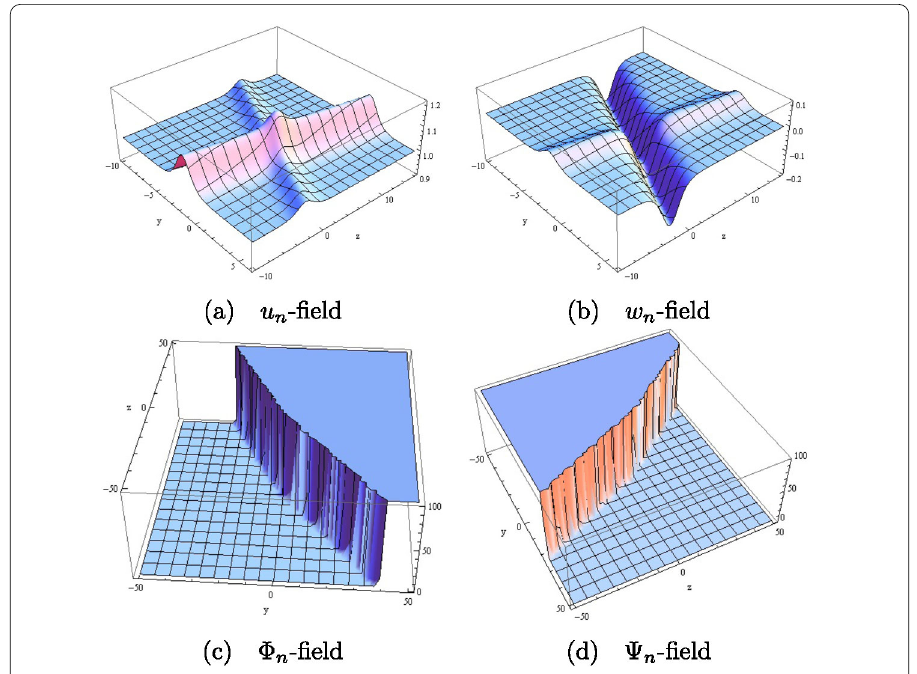
Figure 2 Interactions of two solitons in ( a ) and ( b ) with the sources (cid:8) n and (cid:9) n as in ( c ) and ( d )